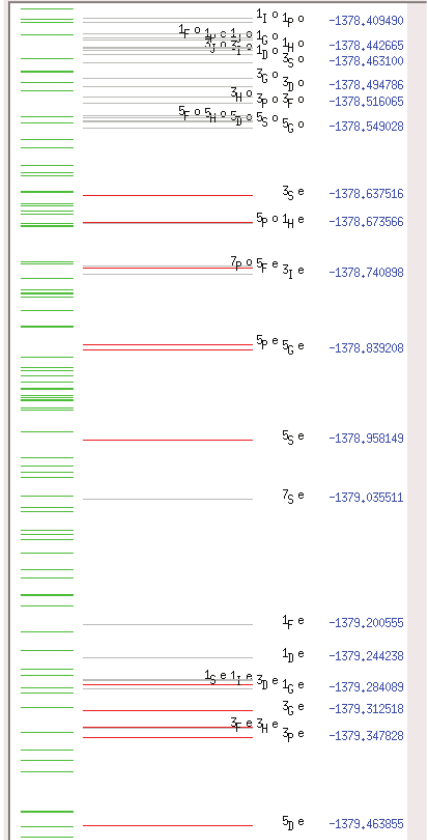
F 1: e graphical abstraction of the R -matrix H-�le as given from H�rowse code, a �raphical R -matrix Atomic Collision environment: six LS- coupled states are included into the R -matrix expansion: quantum number 0 L 9, 2 (2 S + 1) 8, maximum number of channels 18, R -matrix radius 15 a.u, Hamiltonian size 290, and scattering F e . symmetry 3𝑝𝑝 < < < < 4